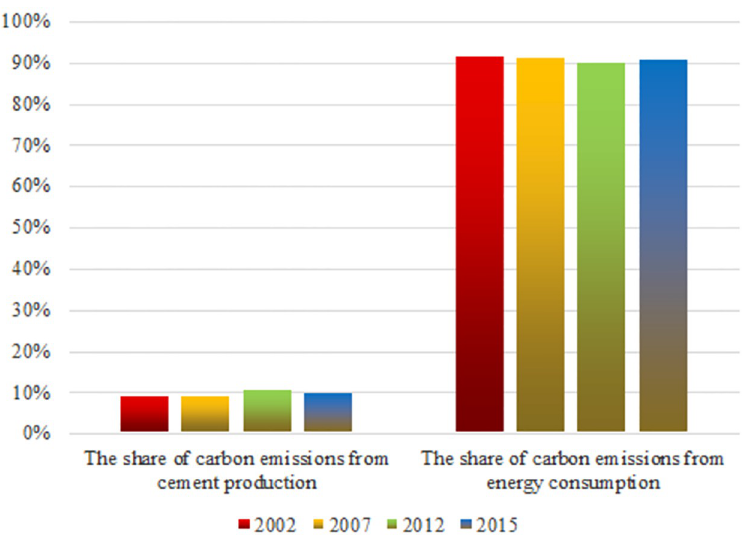
Fig 1. The share of cement production carbon emissions and energy consumption carbon emissions.